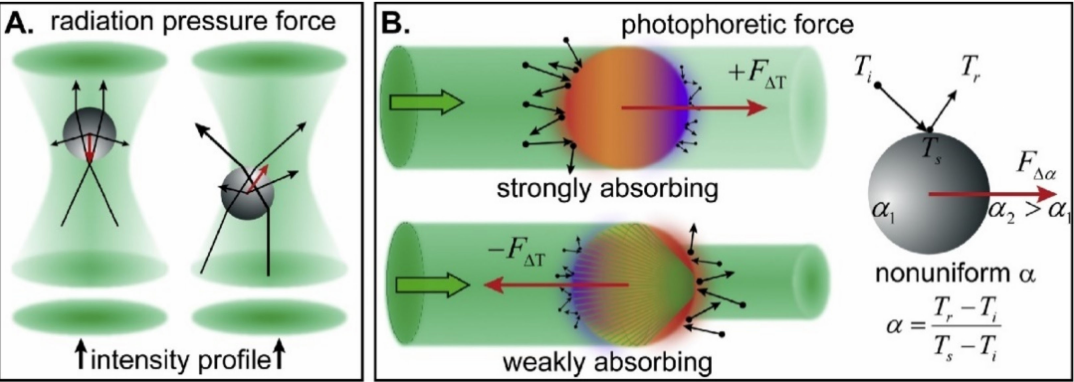
Figure 1. ( A ) A ray-optics description of the radiation-pressure force on a transparent sphere. ( B ) The photophoretic forces include the ∆ T-force and the ∆ α -force. The inhomogeneous heating on strongly and weakly absorbing spheres results in positive and negative ∆ T -forces. The ∆ α -force can exist in a particle with non-uniform thermal accommodation coefficient α , even when the particle has a uniform temperature (reprinted from [56] with permission from Elsevier, Copyright (2018)